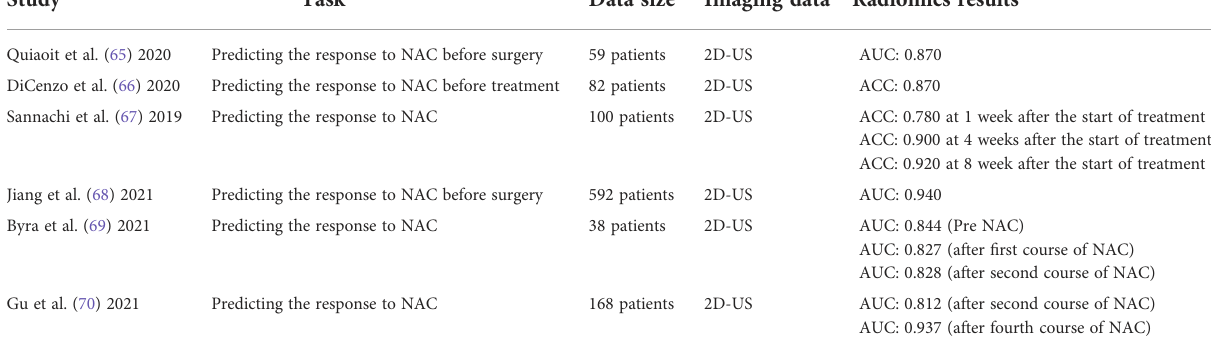
TABLE 4 Summary of ultrasound radiomics studies in predicting response of NAC.